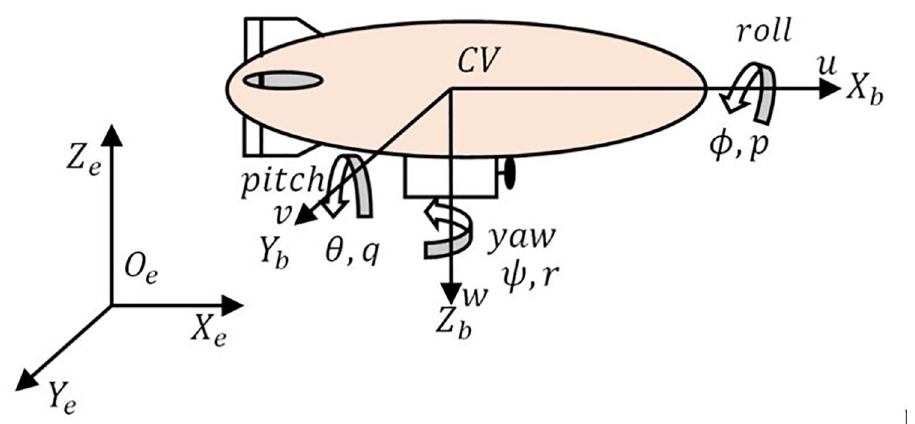
Fig 1. The coordinate system of an